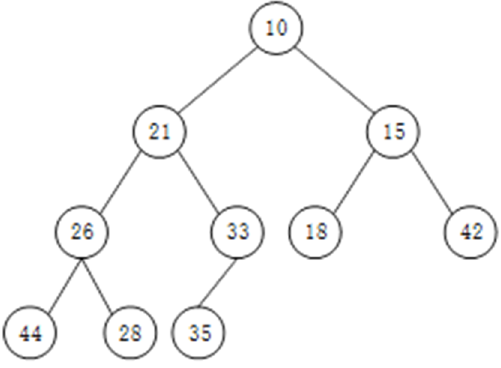
Figure 20. A binary heap stores data structures.